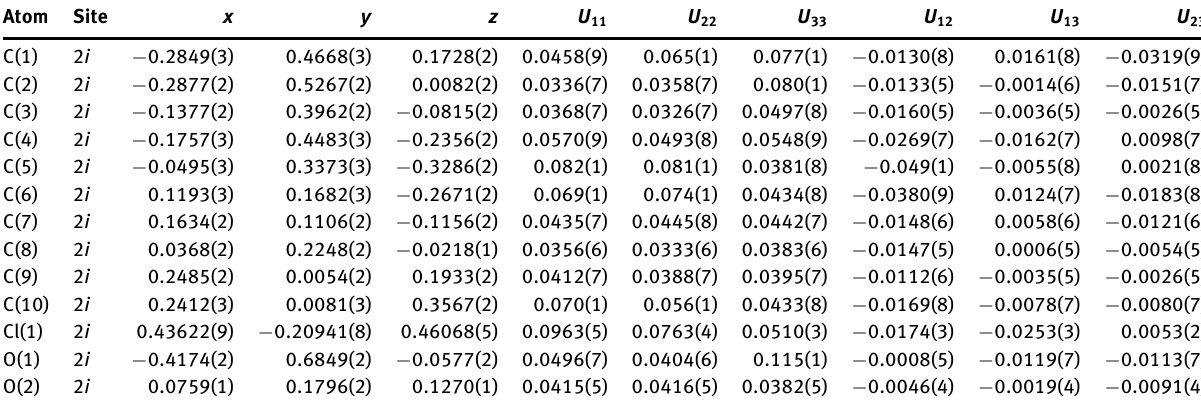
Table 3: Atomic displacement parameters (Å 2